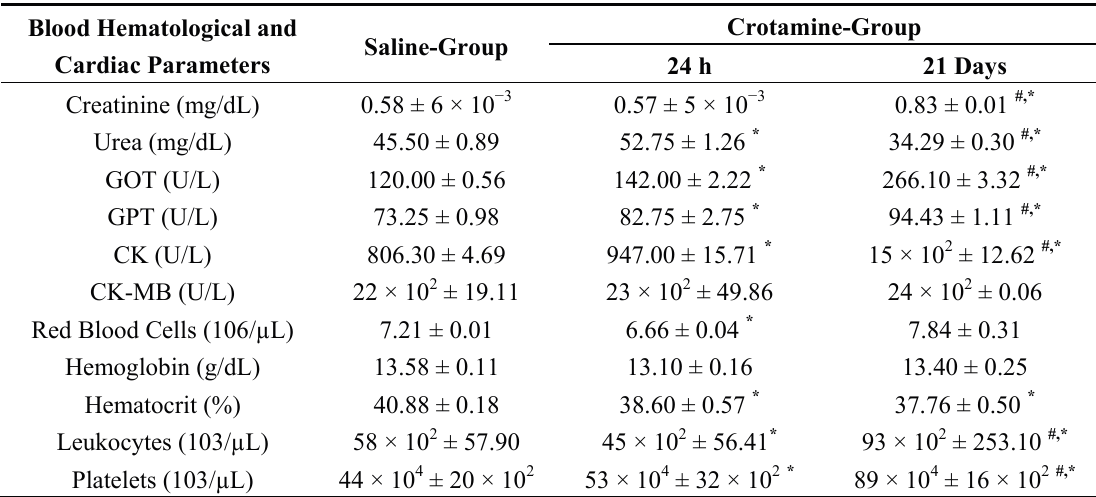
Table 1. Results of blood hematological and cardiac parameters. The intrahippocampal infusion of crotamine altered some measurements 24 h and 21 days after infusion. Data are expressed as mean ±